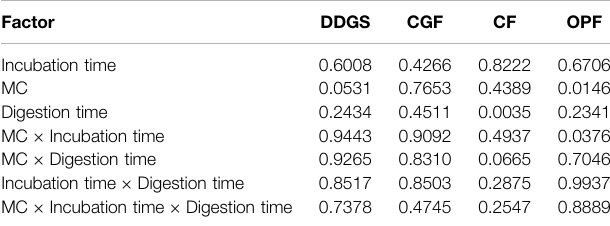
Factors: MC – 30 and 50% db; Incubation time – 24 and 72 h; Digestion time – 24 and 72 h. DDGS, distillers dried grains with solubles; CGF, corn gluten feed; CF, corn fi ber; OPF, oil palm